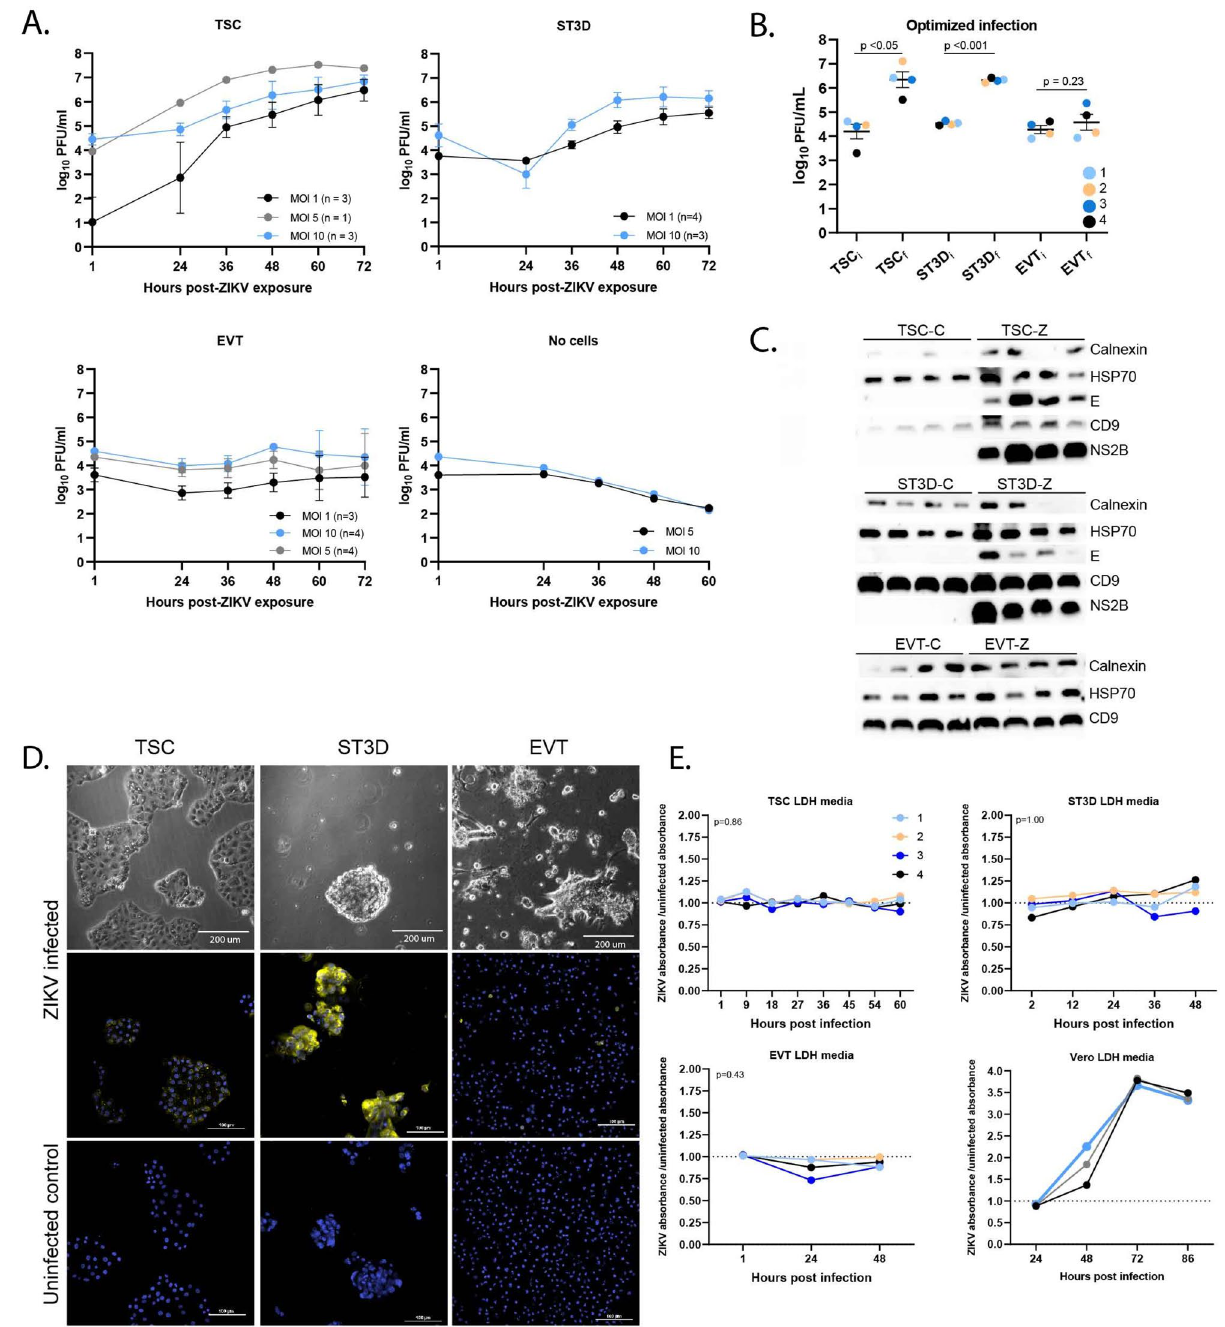
Figure 1. Early gestation trophoblast cells are permissive to ZIKV infection. ( A ) Quantification of infectious virus by plaque assay in a time course and multiplicity of infection (MOI) dose response for each cell type (TSC, ST3D, EVT, or “no cells”). The number of cell lines tested, n, is indicated within parentheses next to the MOI. The quantity of infectious virus detected at each time point represents accumulated virus over time since the previous time point from the same well. ( B ) Quantification of infectious virus by plaque assay with optimized MOI and duration of culture (i subscript = initial time point; f subscript = final time point) for each cell type and cell line (indicated by circle color). The mean plaque forming units (PFUs) ± the standard error of the mean (SEM) is shown. A paired t test with Bonferroni correction was used to determine significance. ( C ) Western Blots of ZIKV E, NS2B, CD9, Calnexin, and Heat shock protein 70 (HSP70; loading control) proteins for each cell line (n = 4) and cell type. ( D ) Immunostaining for ZIKV E protein. The top panel shows bright field images of trophoblasts after ZIKV exposure. ZIKV infected cells (middle panels) and control cells (bottom panels) were stained with an antibody against ZIKV E protein (yellow) and a nuclear stain (DAPI; blue). ( E ) Time course of LDH release by TSCs, ST3Ds, EVTs and Vero cells. Trophoblast data is presented as the mean of biological (n = 2–3) and technical replicates at each time point for the four indicated cell lines. The y-axis is presented as ZIKV LDH absorbance/control LDH absorbance, where a value > 1 indicates more cell death in ZIKV exposed cells and a value < 1 indicates less cell death in ZIKV exposed cells. The graph for Vero cell infection represents MOIs of 1 (black), 5 (grey) and 10 (blue). A paired t test was used to determine significance, which is indicated on the